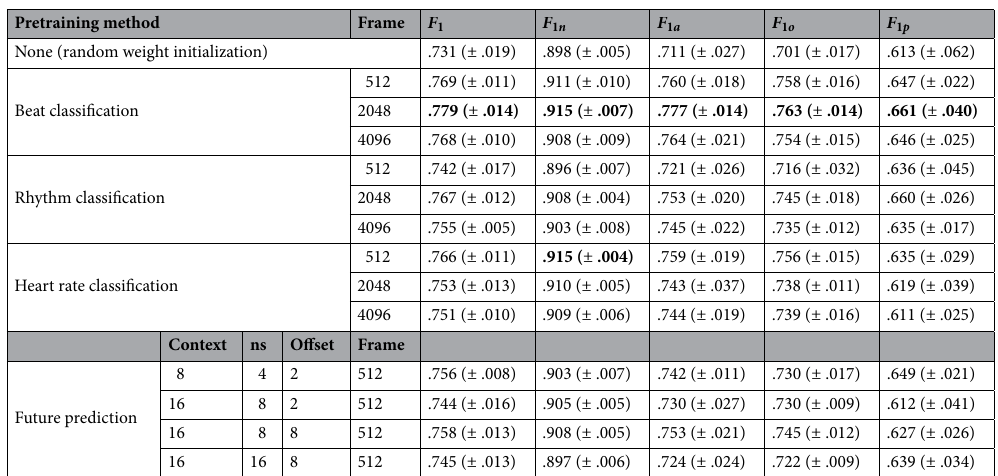
Table 1. Comparison of different configurations of the pretraining methods. For each method, we report the average macro F 1 score (and the standard deviation) on our test set for the PhysioNet/CinC Challenge 2017 7,8 . Additionally, we report the average F 1 score for each class: normal ( F 1 n ), AF ( F 1 a ), other ( F 1 o ) and noisy ( F 1 p ). Frame refers to the length of an ECG frame, context to the number of frames in the context, ns to the number of negative samples and offset to the distance between the context and the future frame measured in frames. All pretraining methods outperform random weight initialization in predicting every